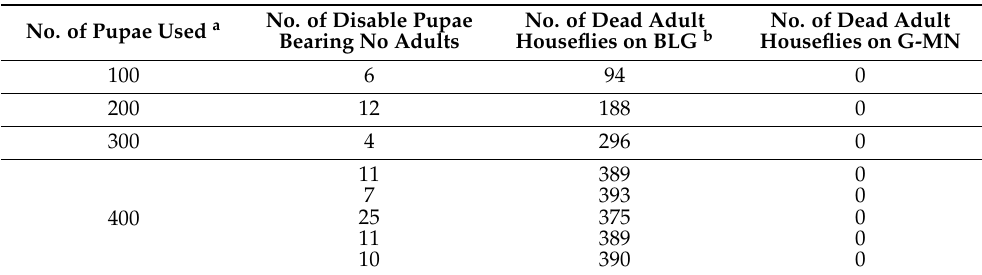
Table 2. Evaluation of the ability of the arc-discharge exposer (ADE) to control adult houseflies emerging from underground pupae by continuous pulsed arc-discharge exposures.